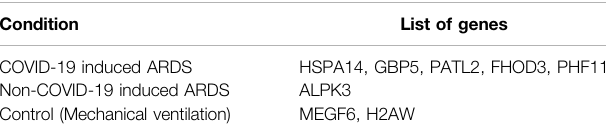
TABLE 3 | List of differentially expressed genes in